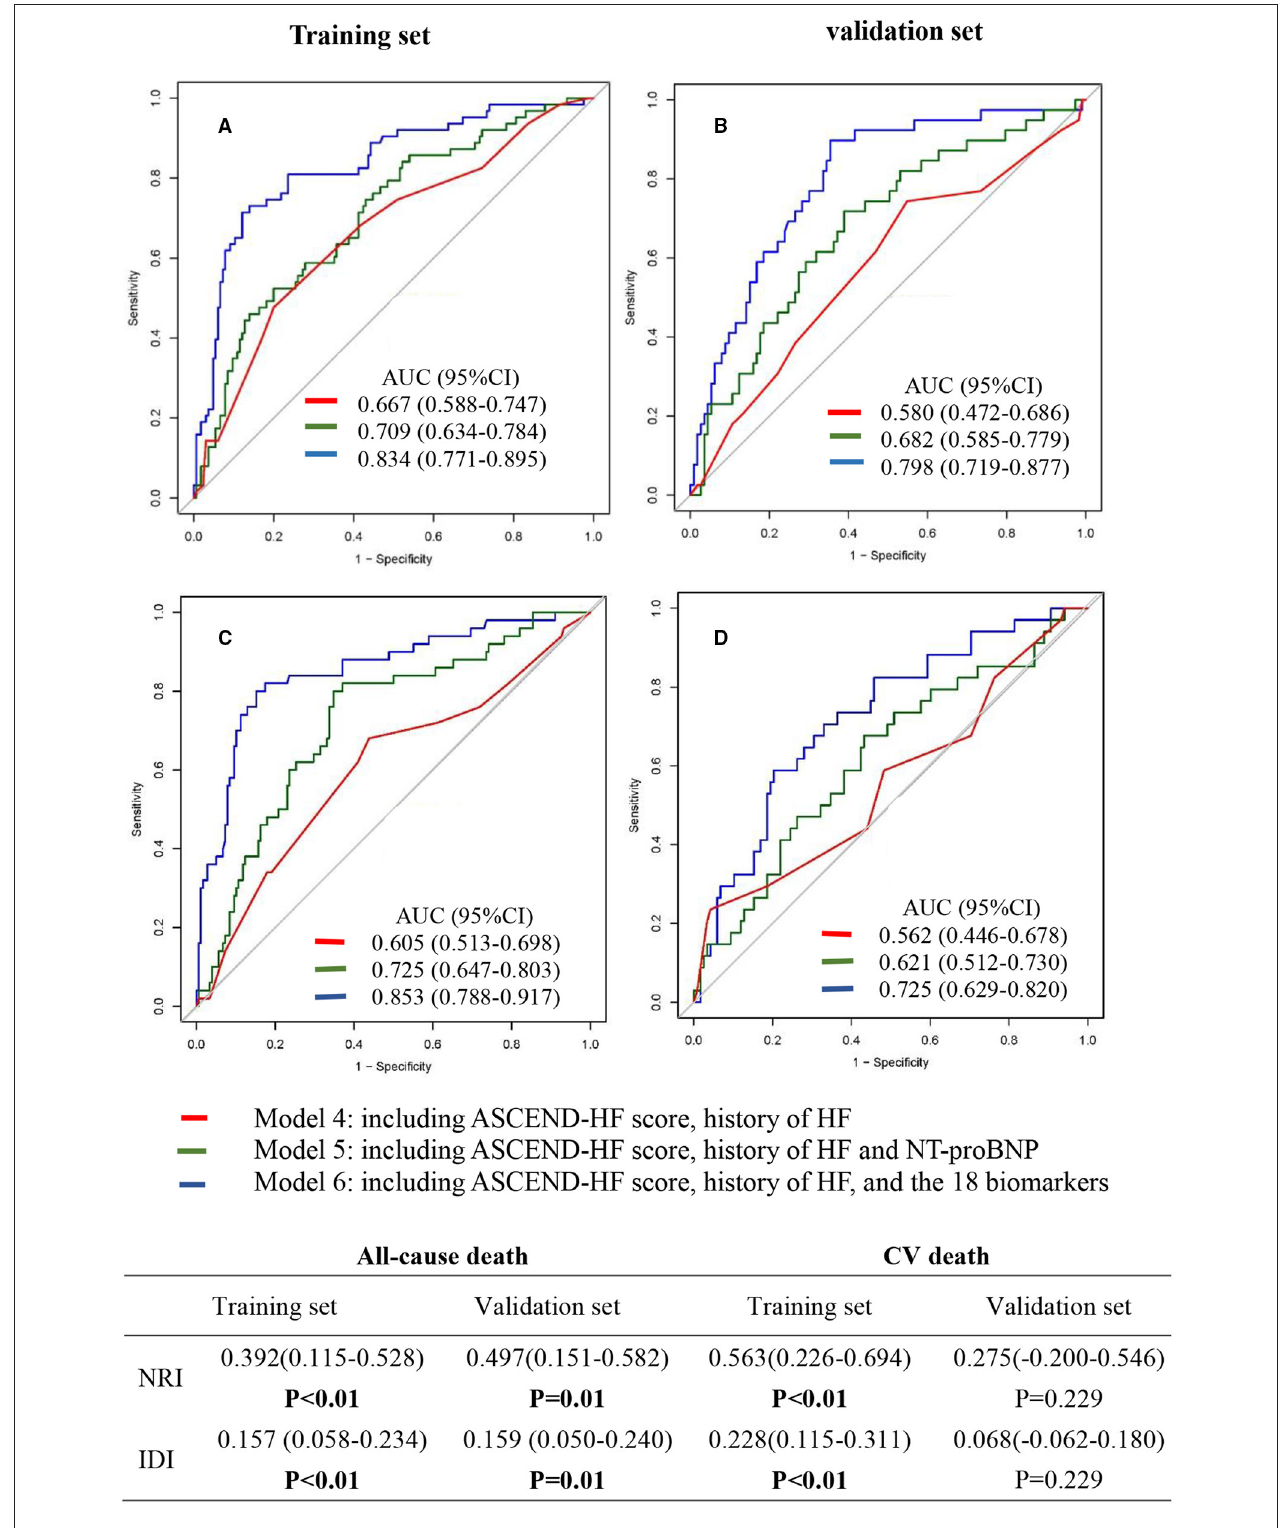
FIGURE 2 | Receiver operating characteristic (ROC) curve of multi-marker models for predicting the 2-year risk of all-cause death (A,B) and cardiovascular death (C,D) . Model 4 included ASCEND-HF score and history of HF. Model 5 included ASCEND-HF score, history of HF, and NT-proBNP. Model 6 included ASCEND-HF score, history of HF, and 18 candidate biomarkers (log-NT-proBNP, hs-TNT, hs-CRP, Endoglin, sTNFRI, sTNFRII, TIMP-1, TIMP-2, MMP-2, MMP-8, MMP-9, Galectin-3, MCP-1, TNF α , GDF-15, Lipocanlin-2, Cystatin-C, sST2). NRI, net reclassification improvement; IDI, integrated discrimination improvement.